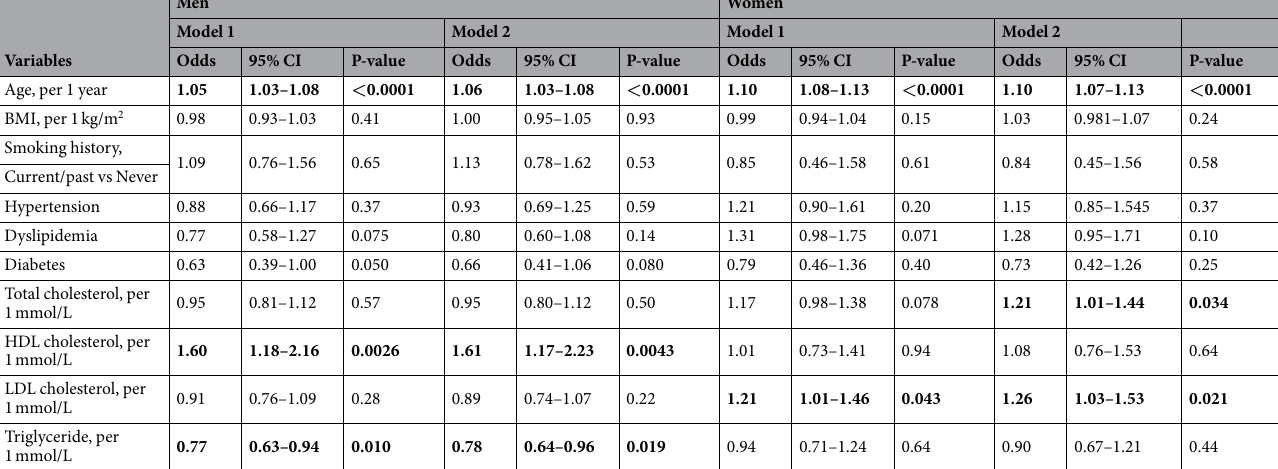
Table 3. Logistic regression analysis of factors for early AMD according to sex. HDL: high-density lipoprotein, LDL: low-density lipoprotein; Significant values are in bold. Model 1: Adjusted for age. Model 2: For serum lipid: adjusted for age, BMI, smoking history, hypertension, diabetes, and lipid-lowering medication. For the others: adjusted for age, BMI, smoking history, hypertension, dyslipidemia, and diabetes.